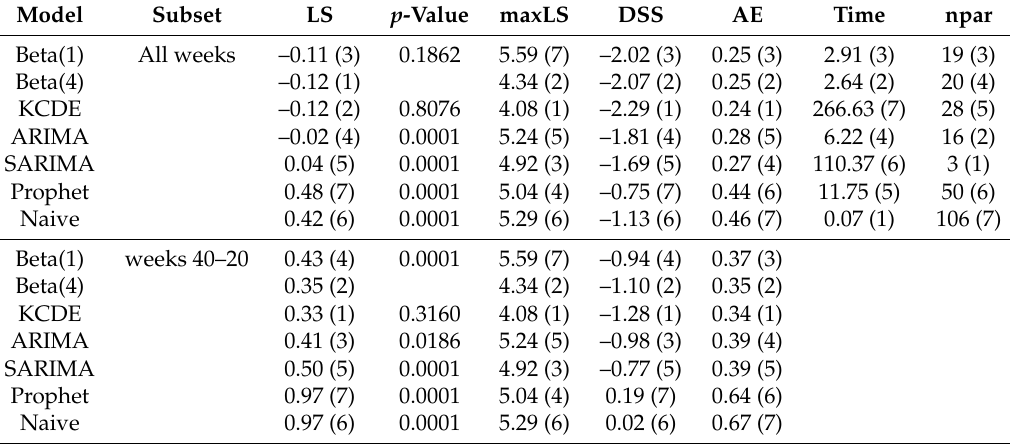
Table 1. Model performance in terms of log score (LS), Dawid-Sebastiani score (DSS) and absolute error (AE), averaged over all short-term targets. Ranks are shown in brackets. The “all weeks” group shows average scores over the whole test period (n = 836), whereas the “weeks 40–20” group shows averages over the high incidence periods only (n = 532). The total run times for estimation, reestimation and forecasting at all time points for all prediction horizons are given in minutes. For KCDE, the total run time does not include reestimation. The last column gives the number of estimated parameters. The Monte Carlo p-values for differences in mean log scores are based on 9999 random permutations, comparing each model against Beta(4).